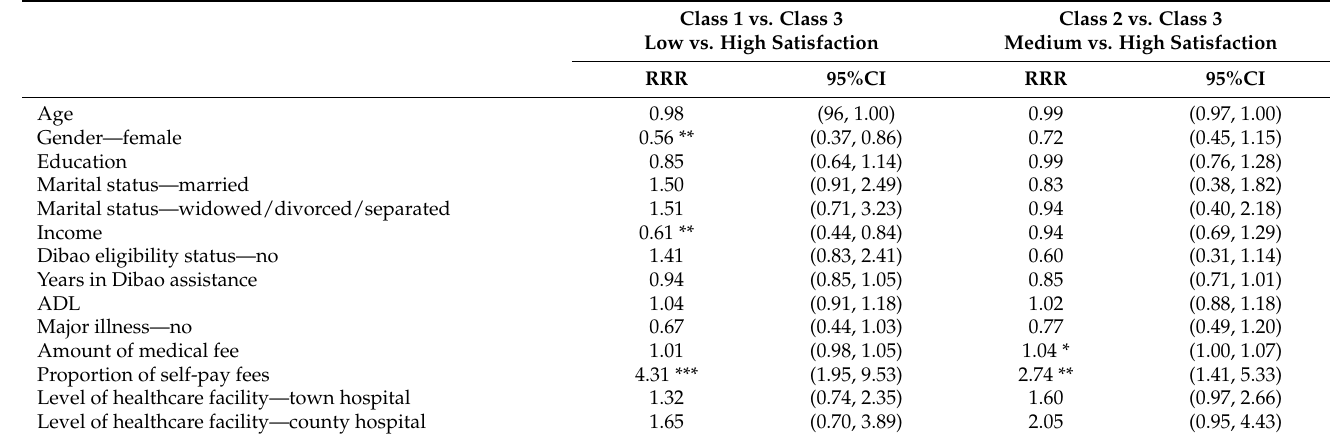
Table 6. Multinomial logistic regression models results predicting outpatient satisfaction class